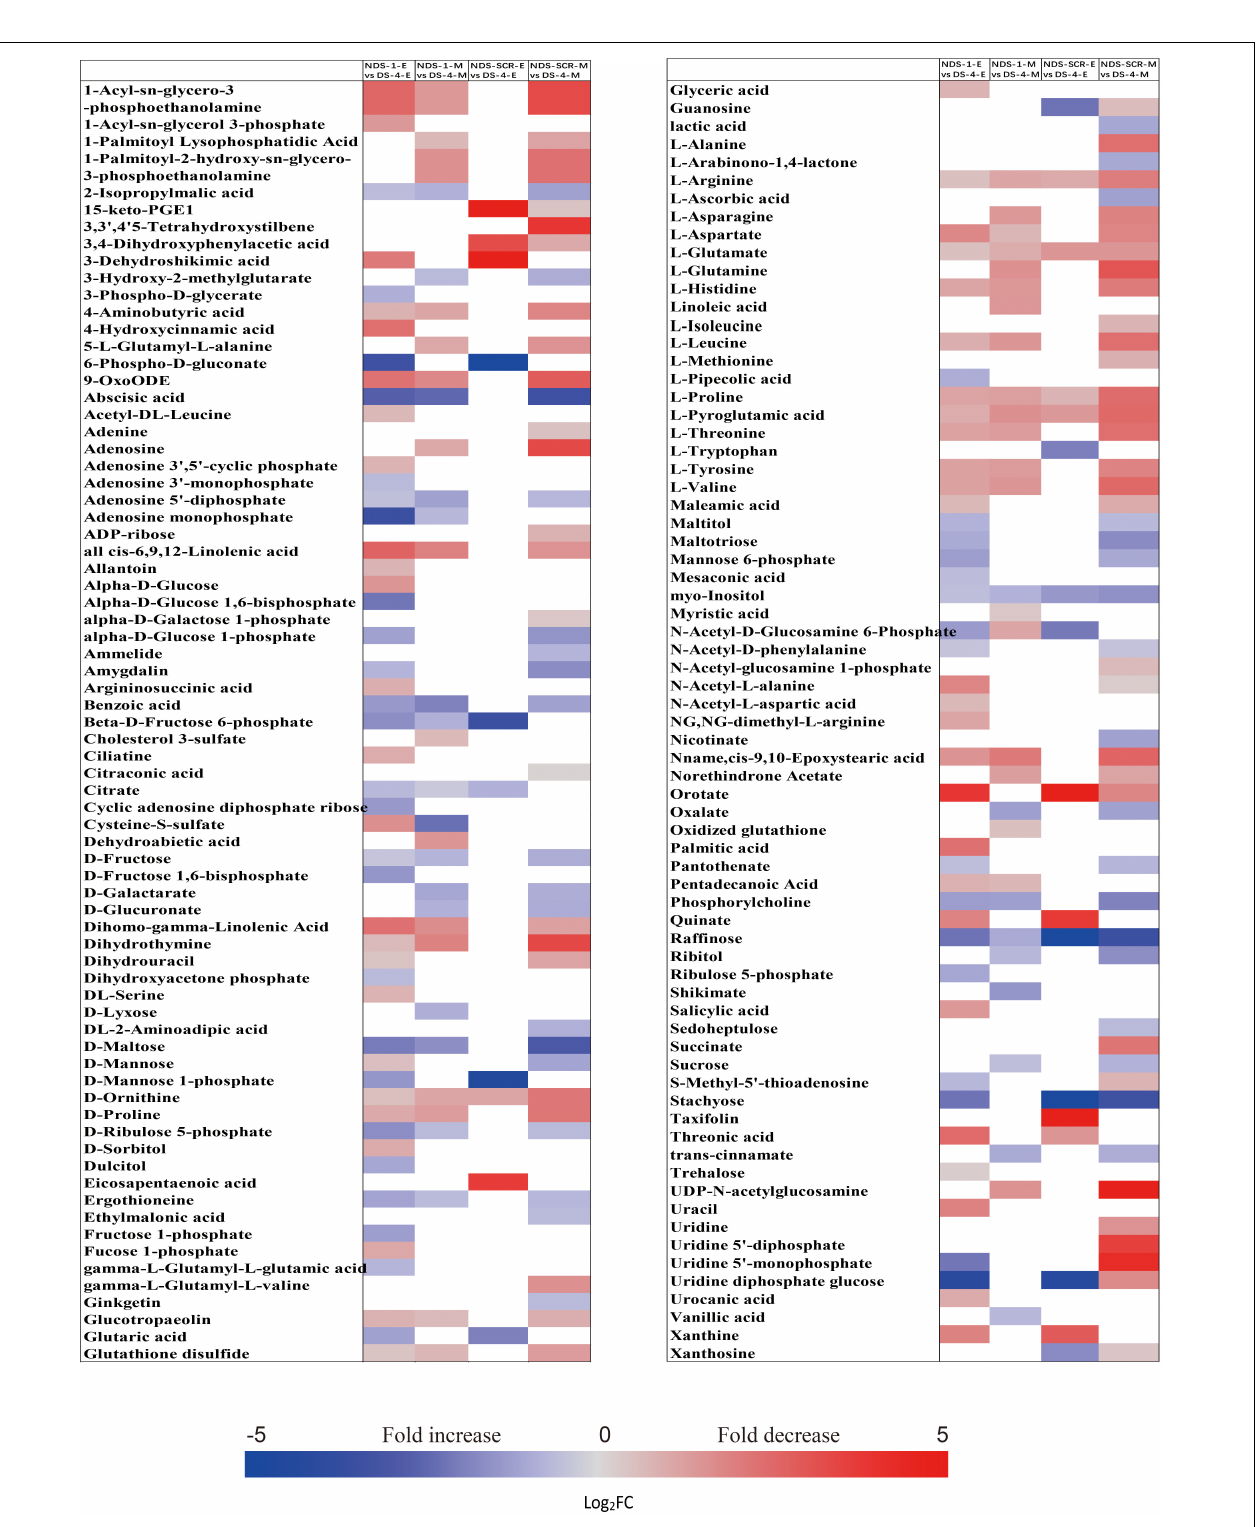
FIGURE 7 | Fold change in the relative contents of important metabolites with VIP value > 1 and P < 0.05 in the embryos (E) and megagametophytes (M) between different types of seeds, such as non-primary physiological dormant seeds (NDS) incubated for 1 week (NDS-1), primary physiological dormant seeds incubated for 4 weeks (DS-4), and NDS with seed coat rupture (NDS-SCR). Fold changes are represented as a heat map. White coloring indicates no significant change. VIP, variable importance in the projection.